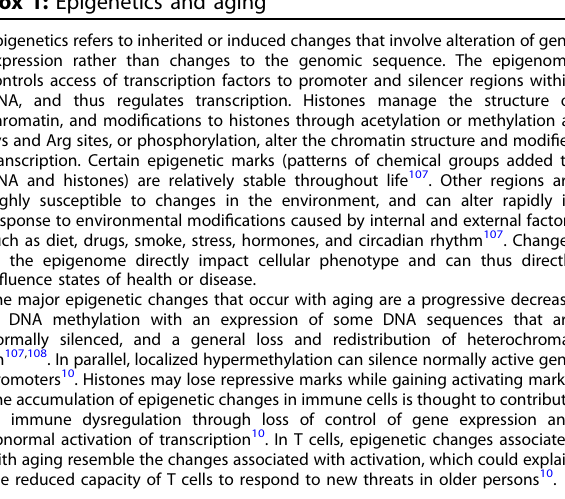
Fig. 1 Changes in the immune system with age. Summary of key changes in the immune system with age. Box 1: Epigenetics and